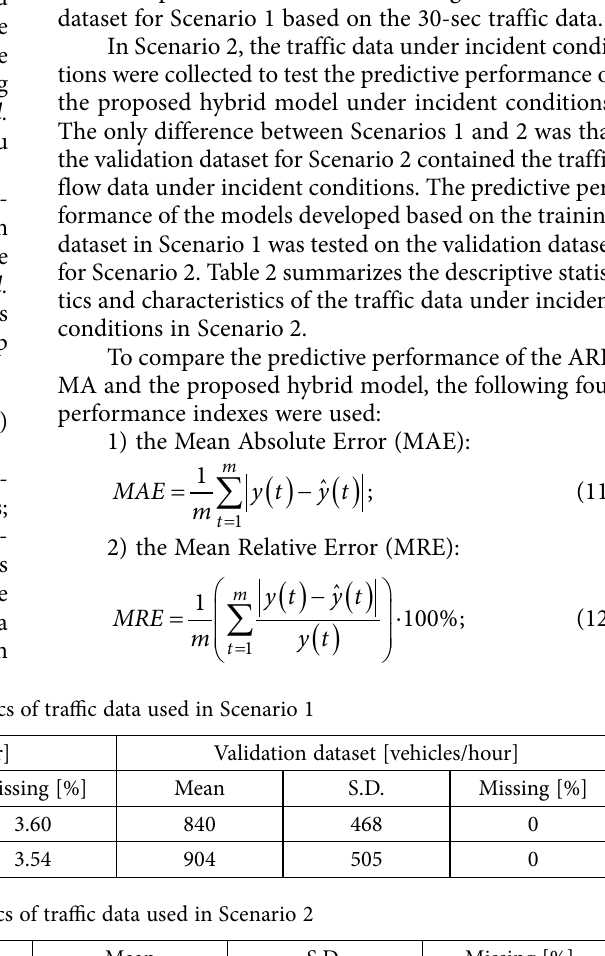
Fig. 3. Study sites of freeway I-880N